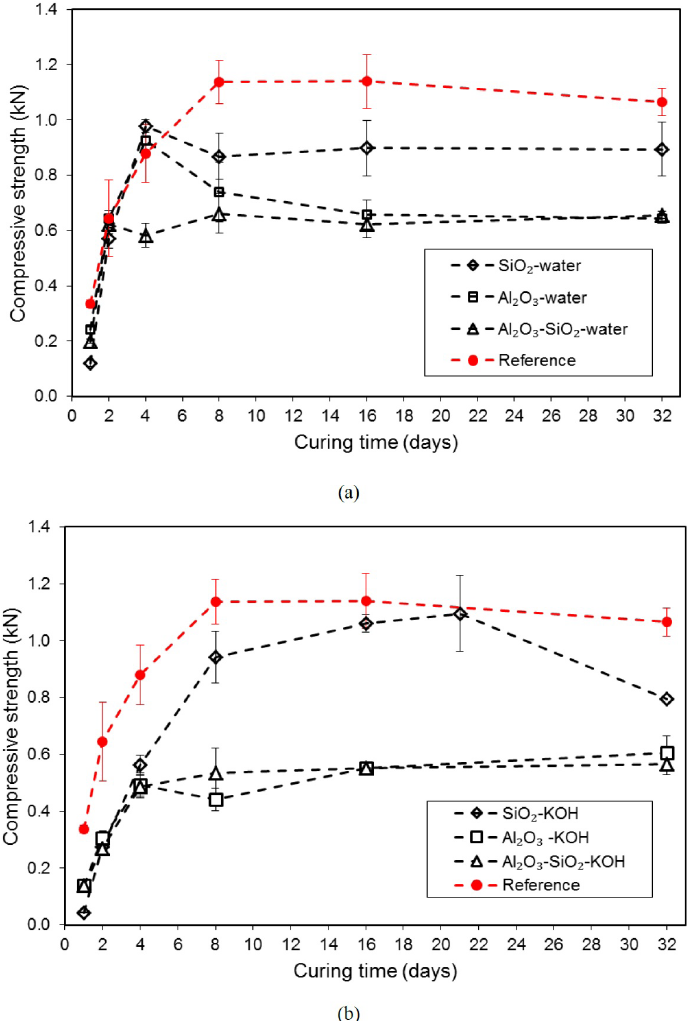
and/or Al O -water pellets (a) and 3 wt% sodium 2 2 3